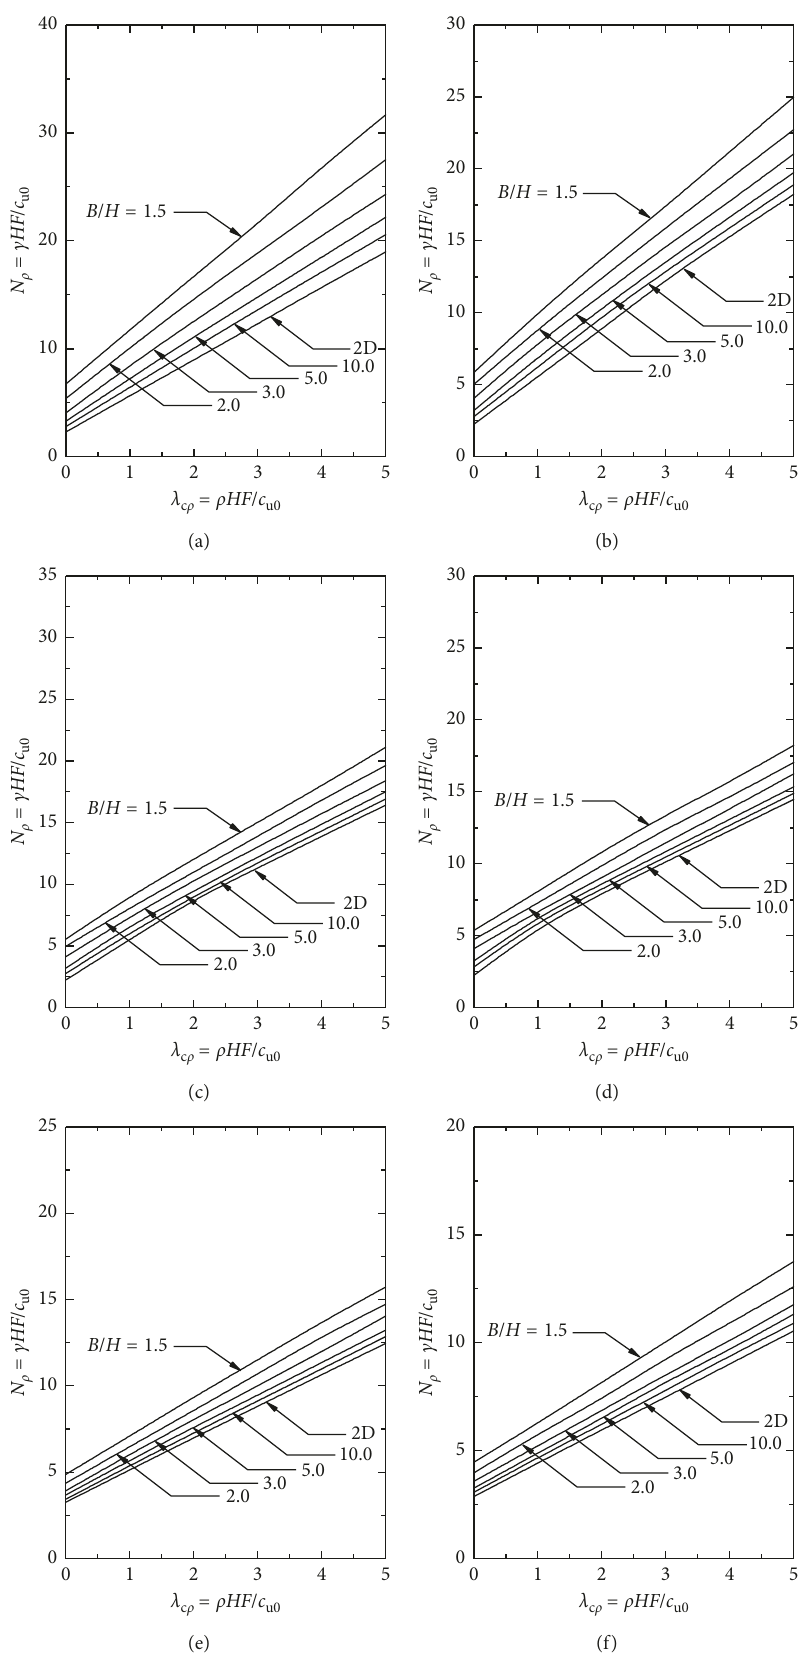
° . (b) β 30 ° . (c) β (cid:31)